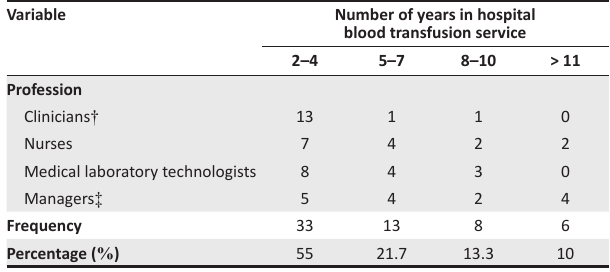
TABLE 1: Profiles of the respondents, Nairobi County, Kenya, June–August 2015. Variable